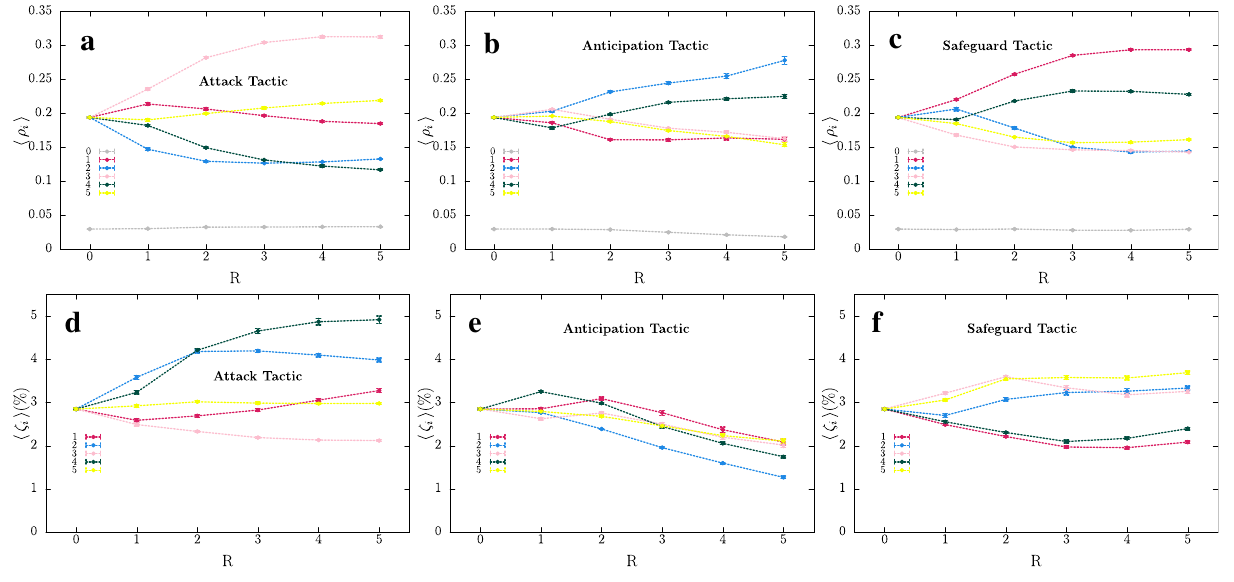
Figure 6. Mean species densities (cid:31) ρ i (cid:30) and mean selection risks (cid:31) ζ i (cid:30) as a function of the perception radius R . R = 0 represents the standard case. ( a ), ( b ), and ( c ) show (cid:31) ρ i (cid:30) for Attack, Anticipation, and Safeguard tactics, respectively. ( d ), ( e ), and ( f ) depict (cid:31) ζ i (cid:30) for Attack, Anticipation, and Safeguard tactics, respectively. The colours are the same as in Figs. 3 and 4. The error bars indicate the standard deviation. The results were obtained using R = 3 and s = r = m = 1 / 3 . The mean values, standard deviation and variation coefficient for Figs. 6a–c